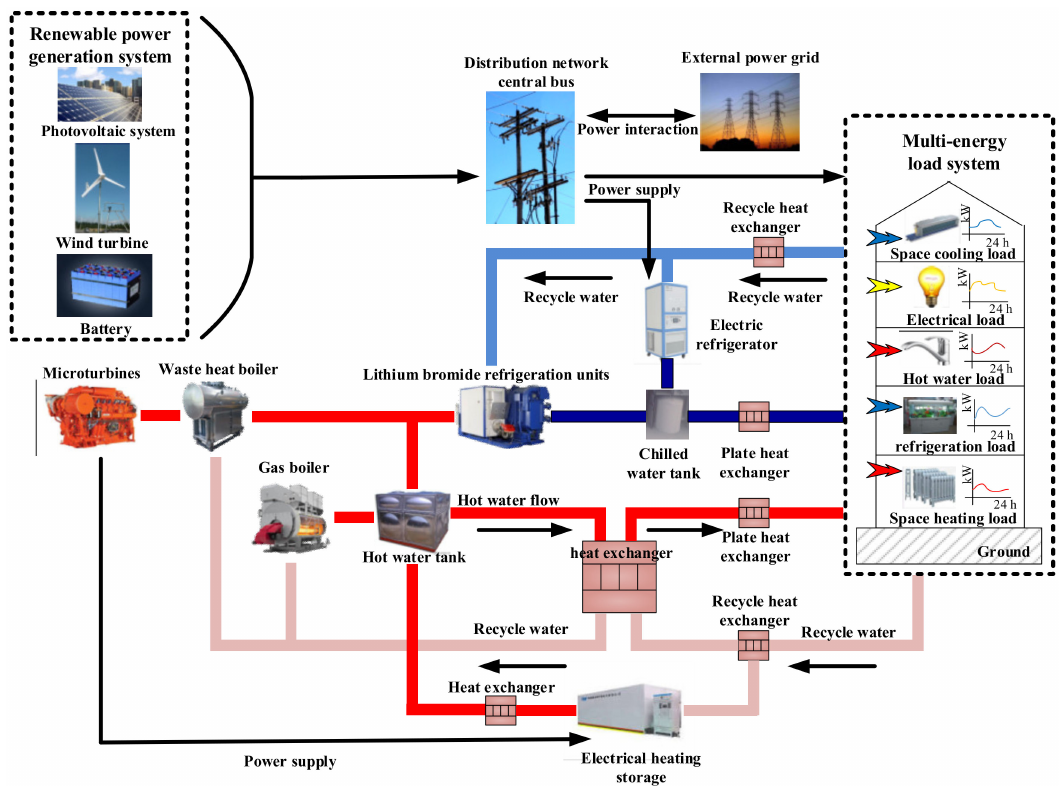
Figure 1. Real-time optimized operation structure of the integrated energy